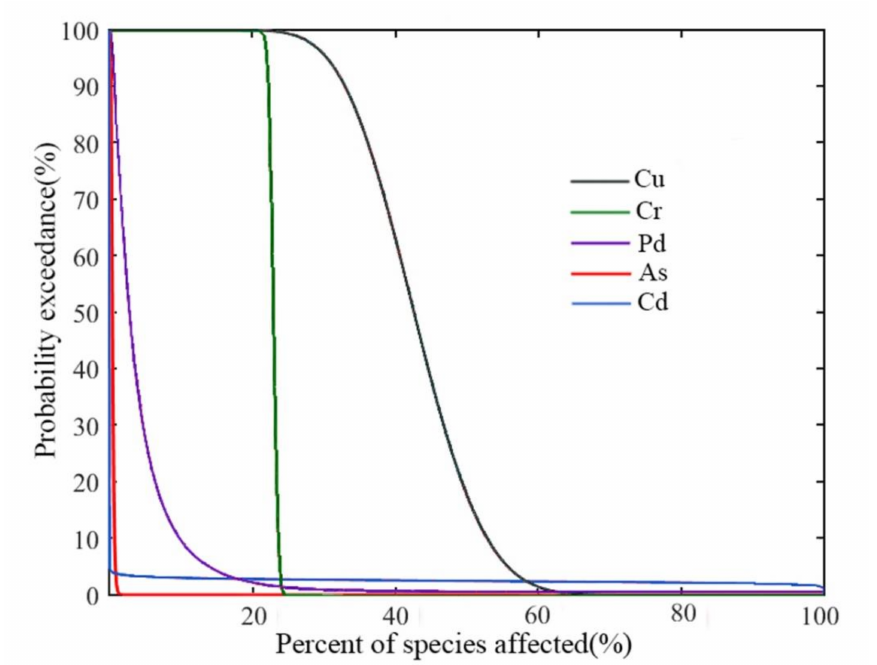
Figure 6. JPCs of the five heavy